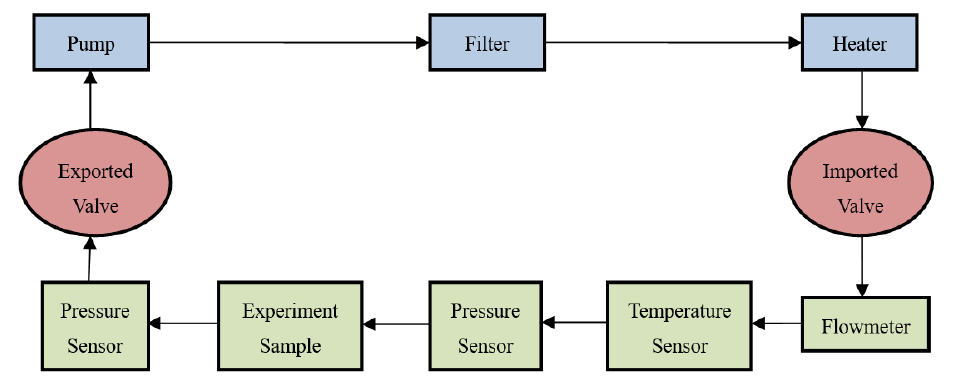
Figure 3. Diagram of connection of experimental platform.